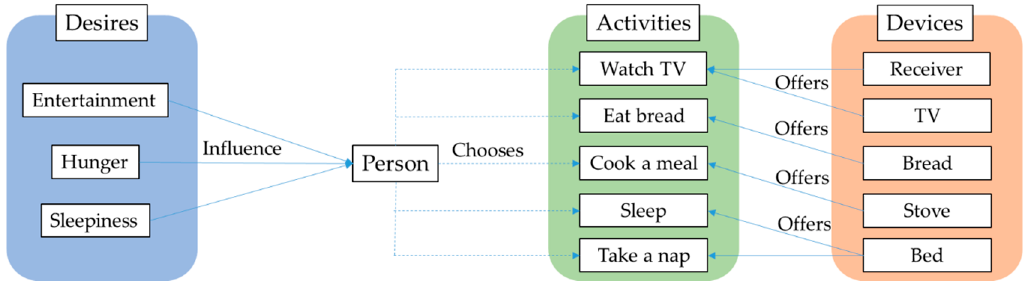
Figure 6. workflow diagram of the load electricity generation [28]. Figure 6. Workflow diagram of the load electricity generation